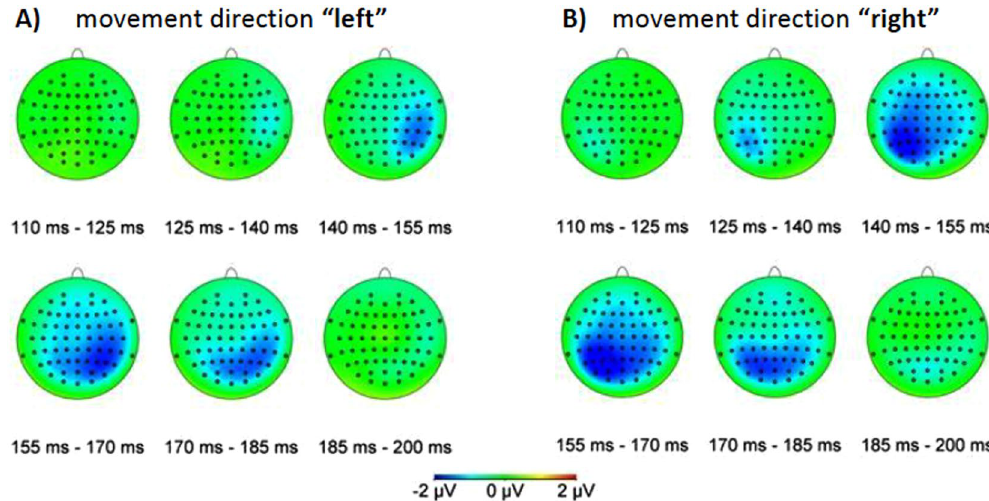
Figure 1. Difference between standard and deviant ERPs for trials in the “central” attention condition. Each plot shows ERP Deviant − ERP Standard , averaged over 15 ms, for different times relative to the reappearance of the moving target. ( A ) target reappearance in the left half of the visual field (“left”); ( B ) target re-appearance in the right half of the visual field (“right”). In both cases the “above” and “below” conditions were averaged. Topographic maps show the differential EEG response signals, with blue indicating negative